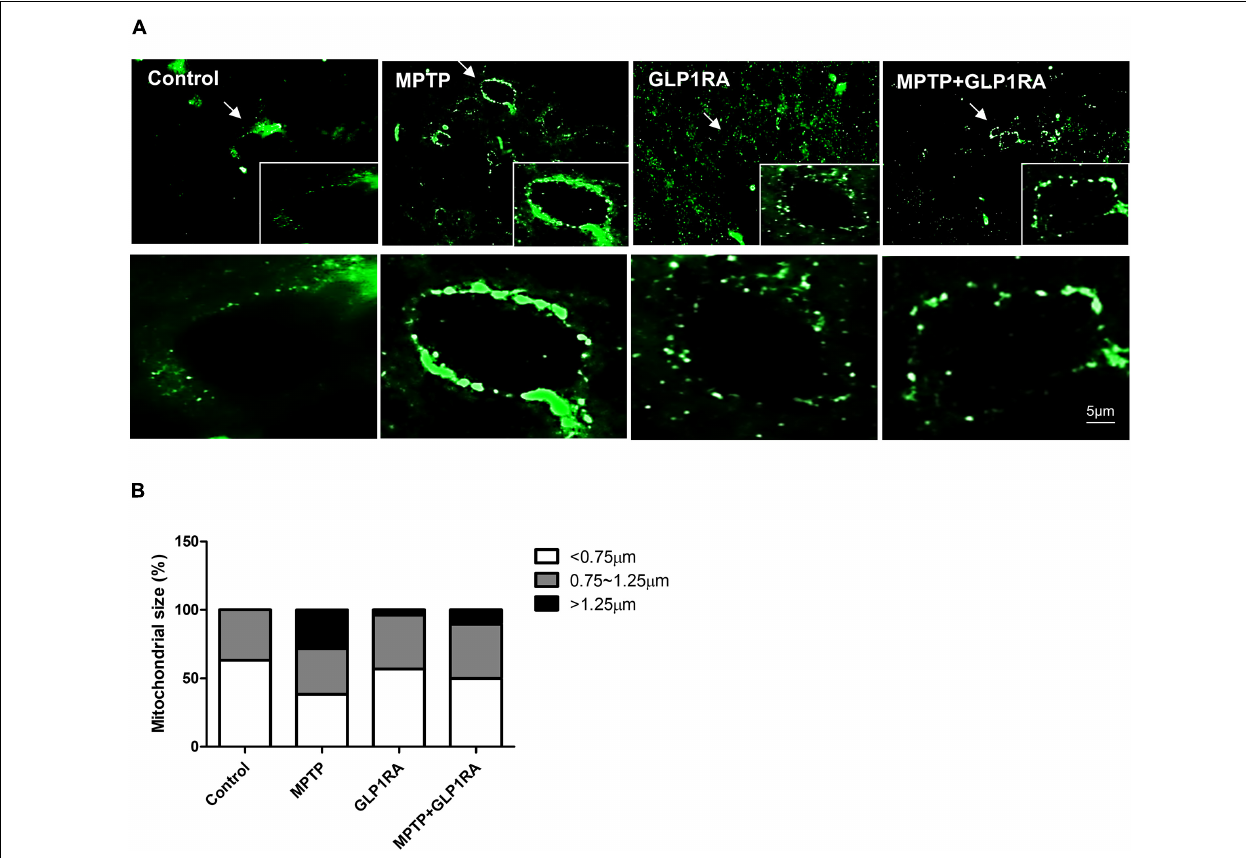
FIGURE 6 | The effect of the GLP-1RA (liraglutide) and MPTP on the morphology of mitochondria in the substantia nigra. Mice were treated according to the four groups: control/MPTP/GLP-1RA/MPTP + GLP-1RA, and sacrificed on the 3rd day. Substantia nigra sections were obtained. (A,B) Representative images of substantia nigra sections immunofluorescence-stained with prohibitin, a mitochondrial scaffold protein (green). Note that representative cells are denoted by arrows. Image was visualized under a 1000x oil fluorescent microscope. Scale bars, 5 µ m. n = 3 per group. The percentage of different sized mitochondria were allocated into three groups: small < 0.75 µ m; medium 0.75 ∼ 1.25 µ m; large > 1.25 µ m. GLP-1RA, glucagon-like peptide-1 receptor